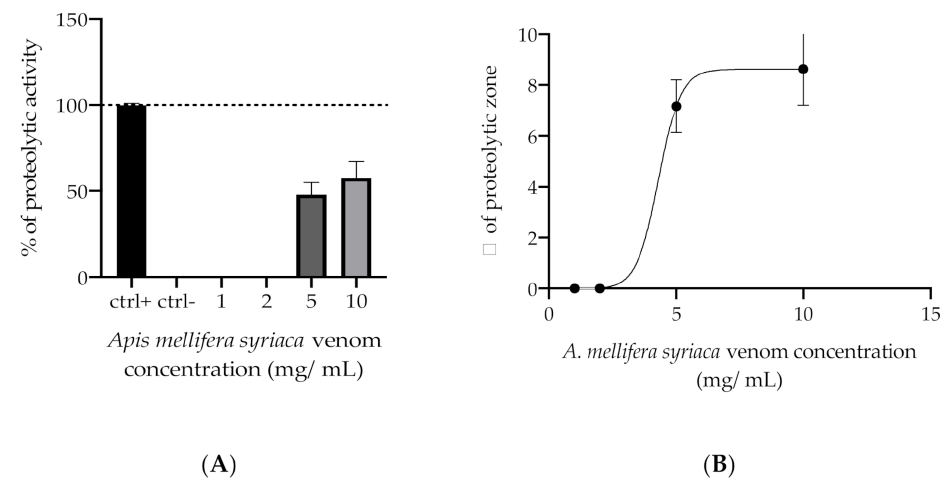
Figure 2. Proteolytic activity of A. mellifera syriaca venom, showing a dose-dependent effect at the concentrations being tested: ( A ) The proteolytic effect percentage of venom at the concentrations tested is presented in comparison with the positive control, inducing a percentage effect of 100% (positive control/pepsin), and the negative control, which has a percentage effect of 0% (negative control/H 2 O). ( B ) The dose–response curve of the venom is presented relative to the diameter of the proteolytic zone observed in the Petri dish, and corresponding to the degradation of casein by the A. mellifera syriaca venom. The results represent the mean ± SD of three independent